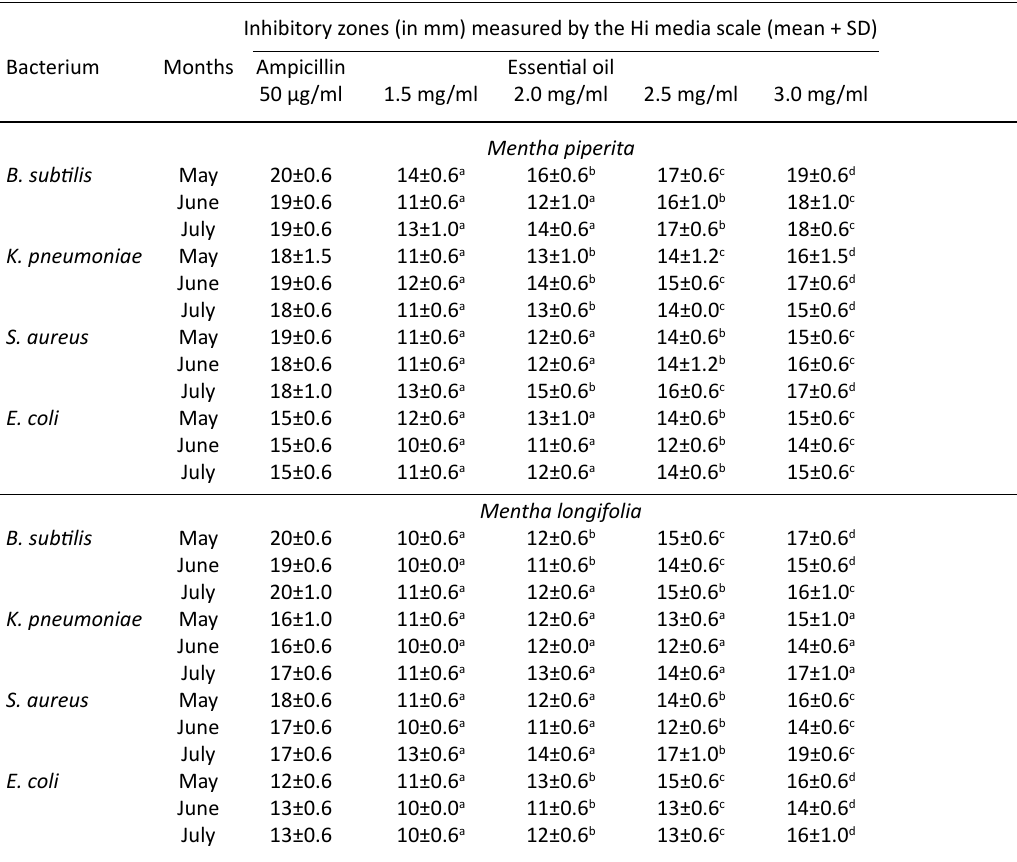
Table 3. Antibacterial activity of essential oil of leaves of M. piperita and M. longifolia Inhibitory zones (in mm) measured by the Hi media scale (mean + SD)